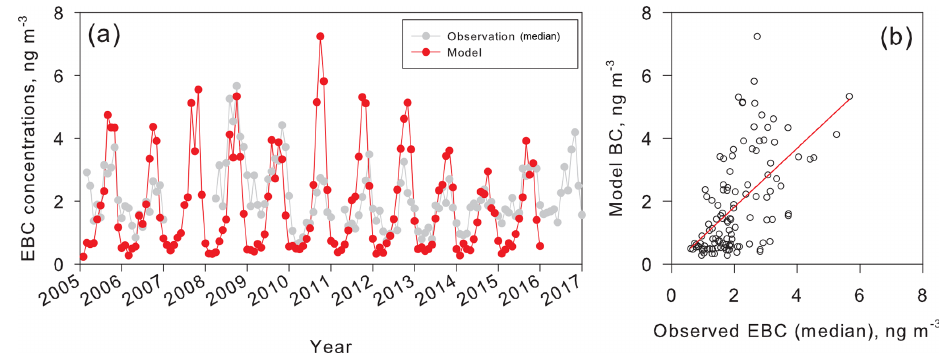
Figure 8. (a) Seasonal features of monthly median EBC concentrations and mBC concentrations at Syowa Station and (b) the relation between monthly median EBC concentrations and mBC concentrations. The red line in (b) shows the regression